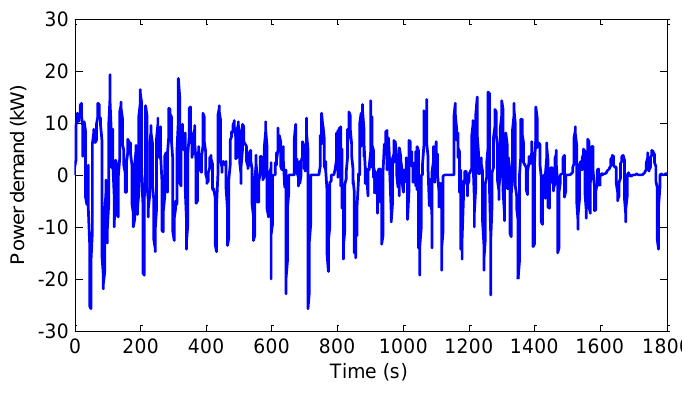
Figure 23. Power demand of the test cycle. Table 2. Main parameters of the tested electric vehicle.